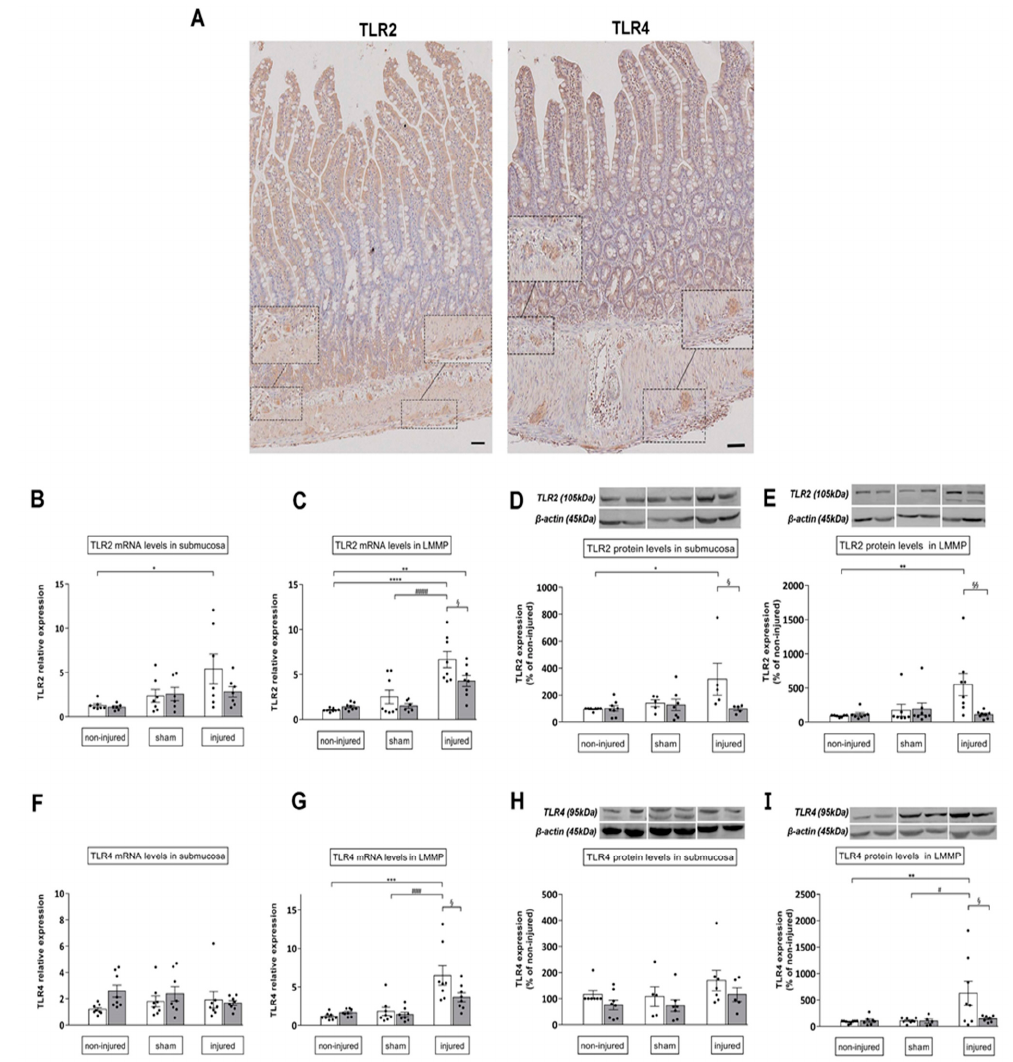
Figure 6. Histochemical, qRT-PCR and Western blotting disclose IRI injury-induced enhancement of TLR2 and TLR4 expression in the rat small intestine. ( A ) Distribution of TLR2 and TLR4 in rat small intestine cross-sections in non-injured conditions. Scale bar = 50 µ m. ( B – E ) Relative expression of mRNA and protein levels of TLR2 ( B , C ) and TLR4 ( F – I ) in the submucosal layer and LMMP preparations obtained from the different experimental groups, with (grey columns) or without (white columns) 4-MU treatment. TLR2 and TLR4 relative gene expression was determined by calculating 2 − ∆∆ Ct values normalized to β -actin, and **** ,#### p < 0.0001, *** ,### p < 0.001, ** p < 0.01, *, § p < 0.05 by one-way ANOVA with Tukey’s post hoc test. Values are expressed as mean ± SEM, n = 6–8. For TLR2 and TLR4 protein expression levels, blots representative of immunoreactive bands for TLR2, TLR4 and β -actin in the different experimental conditions are reported on top of each panel. Samples (200 µ g) were electrophoresed in SDS-8% polyacrylamide gels. Numbers at the margins of the blots indicate relative molecular weights of the respective protein in kDa. Data are expressed as mean ± SEM (n = 6–8) of the optical density (O.D.) ratio of TLR2 and TLR4 vs. β -actin in the different experimental conditions normalized to values obtained in the non-injured group. ** ,§§ p < 0.01, * ,#,§ p < 0.05 by one-way ANOVA with Tukey’s post hoc